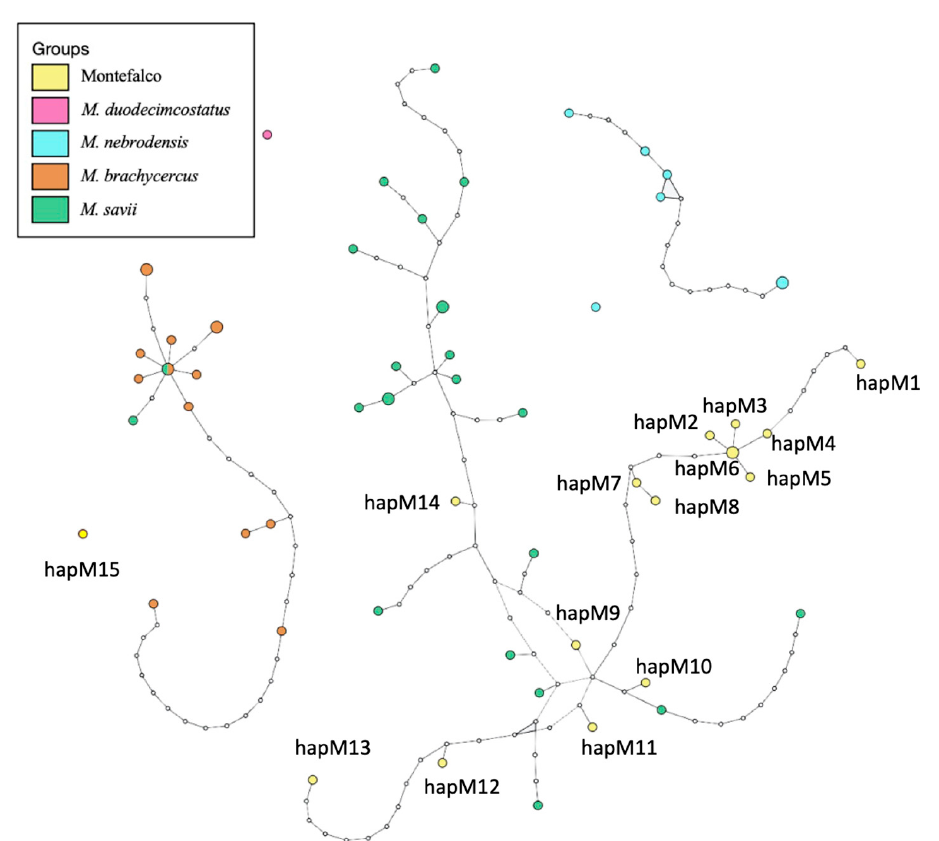
Figure 7. Haplotype minimum spanning network. Each circle represents a unique haplotype, each Microtus species is colour-coded, as reported in the figure key, with Montefalco specimens identified in yellow. The size of the circle is proportional to the number of samples represented by each haplotype.